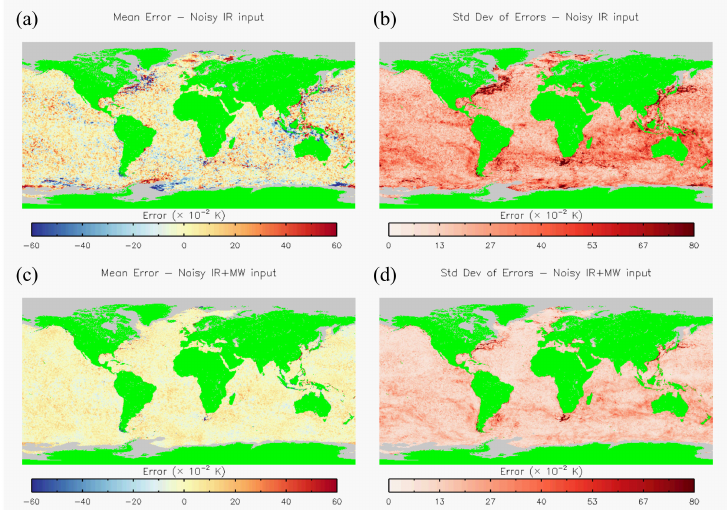
Figure 7. Maps of the error statistics during January for input data with realistic errors: ( a ) mean error with IR data only, ( b ) standard deviation of the error with IR data only, ( c ) mean error with combined IR and CIMR data and ( d ) standard deviation of the error with combined IR and CIMR